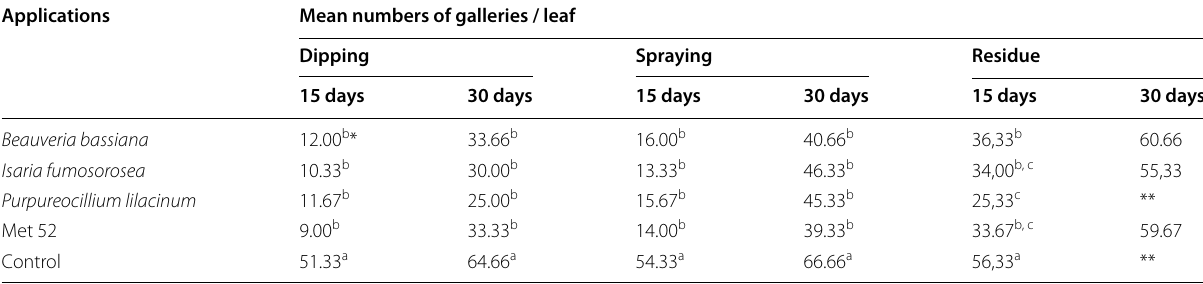
Table 3 Mean numbers of galleries caused by Tuta absoluta on tomato plants, 15 and 30 days after the application of entomopathogenic fungi at three methods in the pot dish